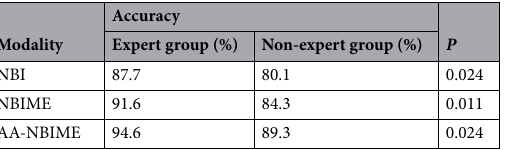
Table 5. Diagnostic accuracy of small colorectal polyps between the expert group and non-expert group for different modalities.